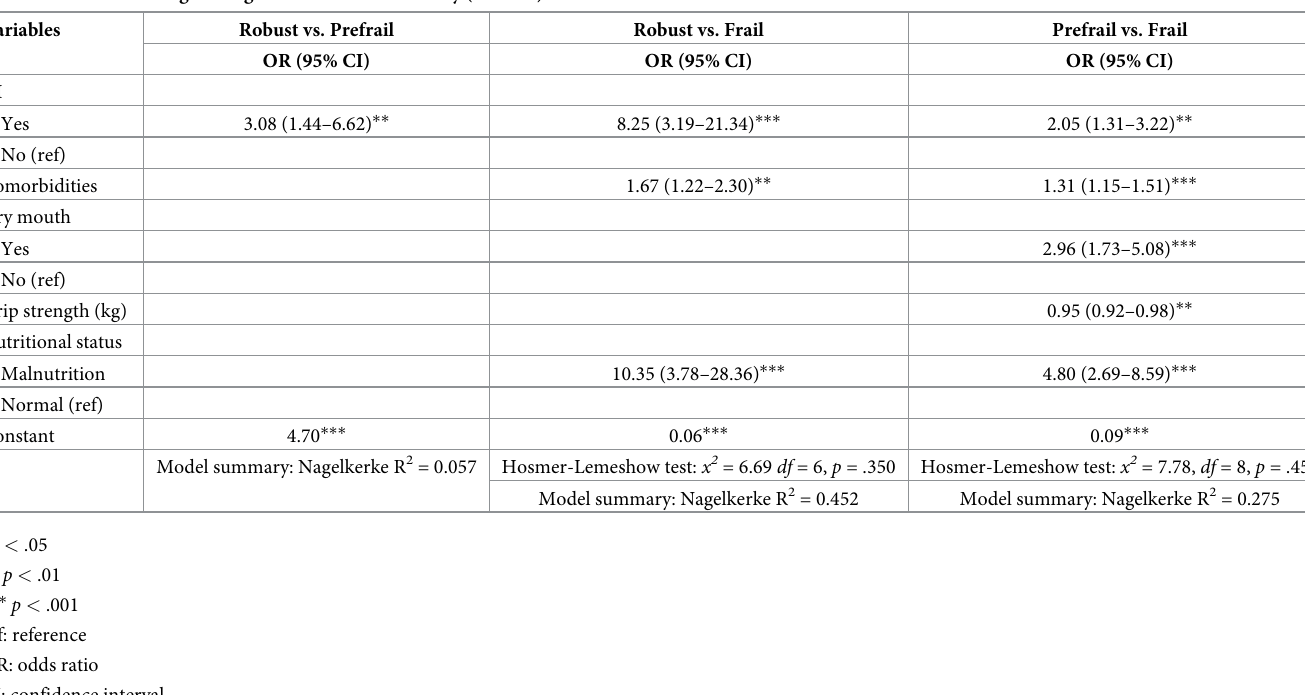
Table 3. Multivariate logistic regression models for frailty (N = 558).